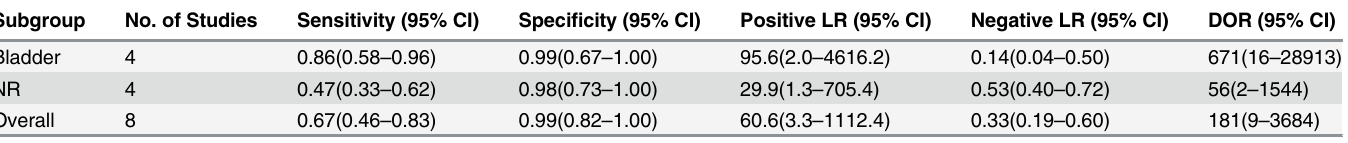
Table 2. Summary results for the ALK diagnostic accuracy for inflammatory myofibroblastic tumours. Subgroup No. of